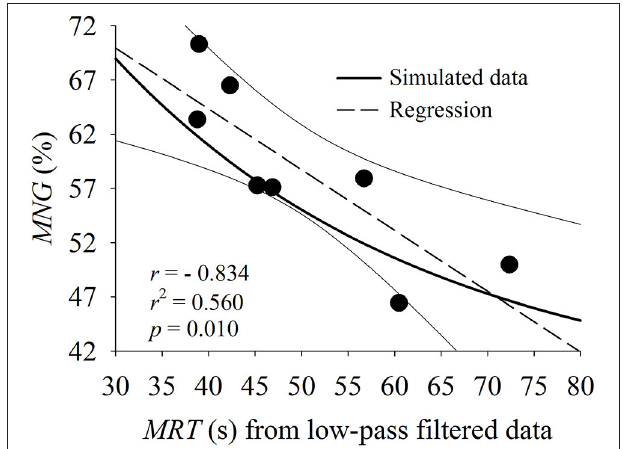
FIGURE 9 | Relationship between mean response time ( MRT ) calculated from filtered oxygen uptake data and mean normalized gain ( MNG ). Both indexes were obtained from eight repetitions for all participants ( n = 8) of the pseudorandom binary sequence test. As the individual values (black circles), the regression line (dashed) and 95% CI (solid thin lines) are shown in comparison to the simulated data (solid thick line for MNG vs. τ s as in Figure 2C